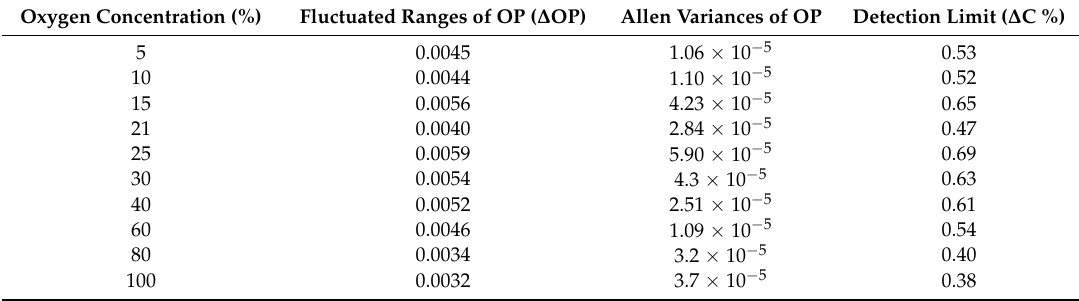
Table A1. Fluctuation ranges of the detected OP and Allen Variances for different oxygen concentrations. Oxygen Concentration